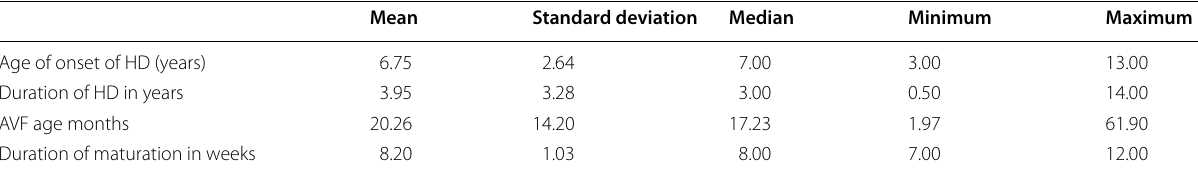
Table 1 Dialysis and AVF onset and